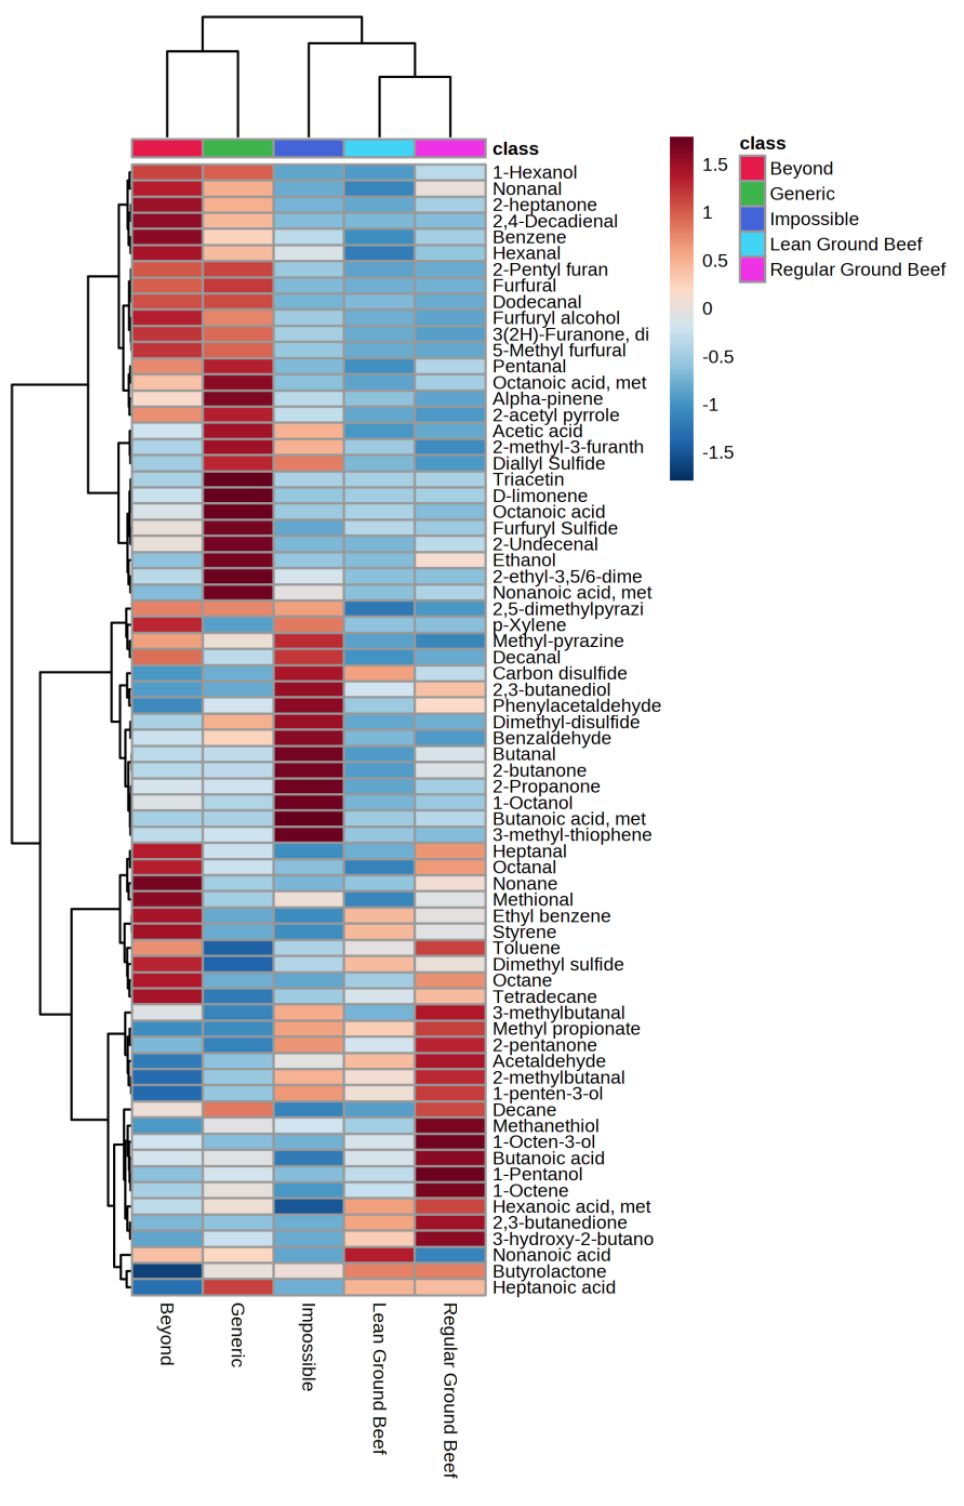
Figure 1. Agglomerative hierarchical clustering of quantitated volatile compound concentration (ng/g) from ground beef and plant-based meat alternatives.